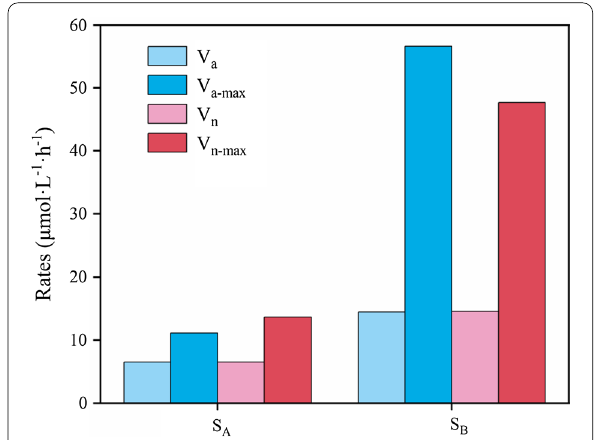
Fig. 2 Average and maximum rates of ammonia oxidation and nitrite DNA extraction and PCR amplification